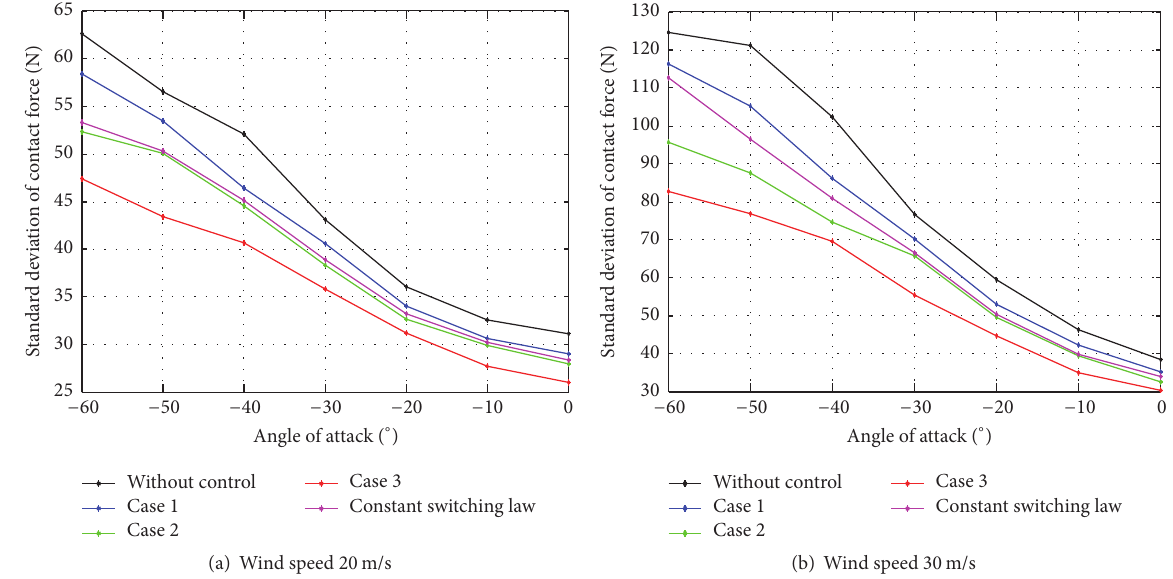
Figure 16: Results of standard deviation of contact force with different wind speeds and angles of attack.